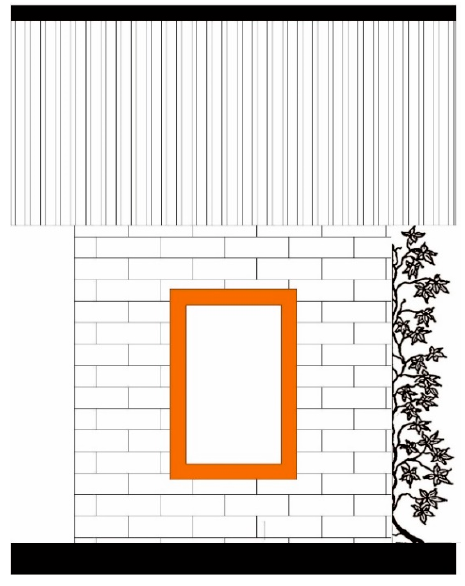
Figure 4. Placement of green facade.